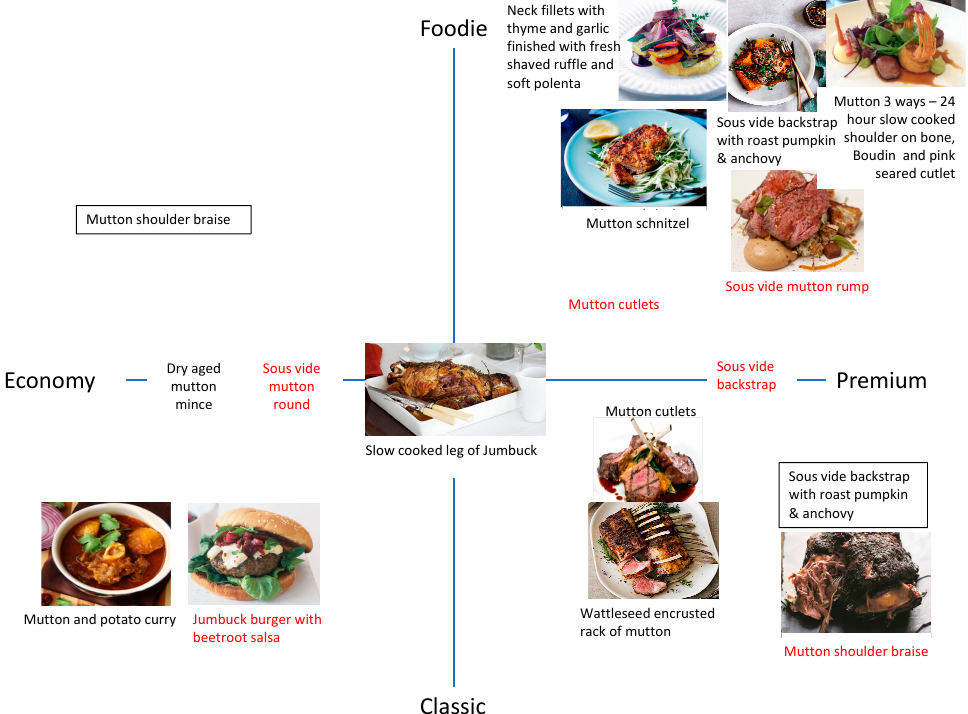
Figure A2. Perth perceptual mapping results; red font denotes tasted dishes, black font denotes image/concepts, and concepts that are enclosed in a black border were mapped more than once as the group could not reach